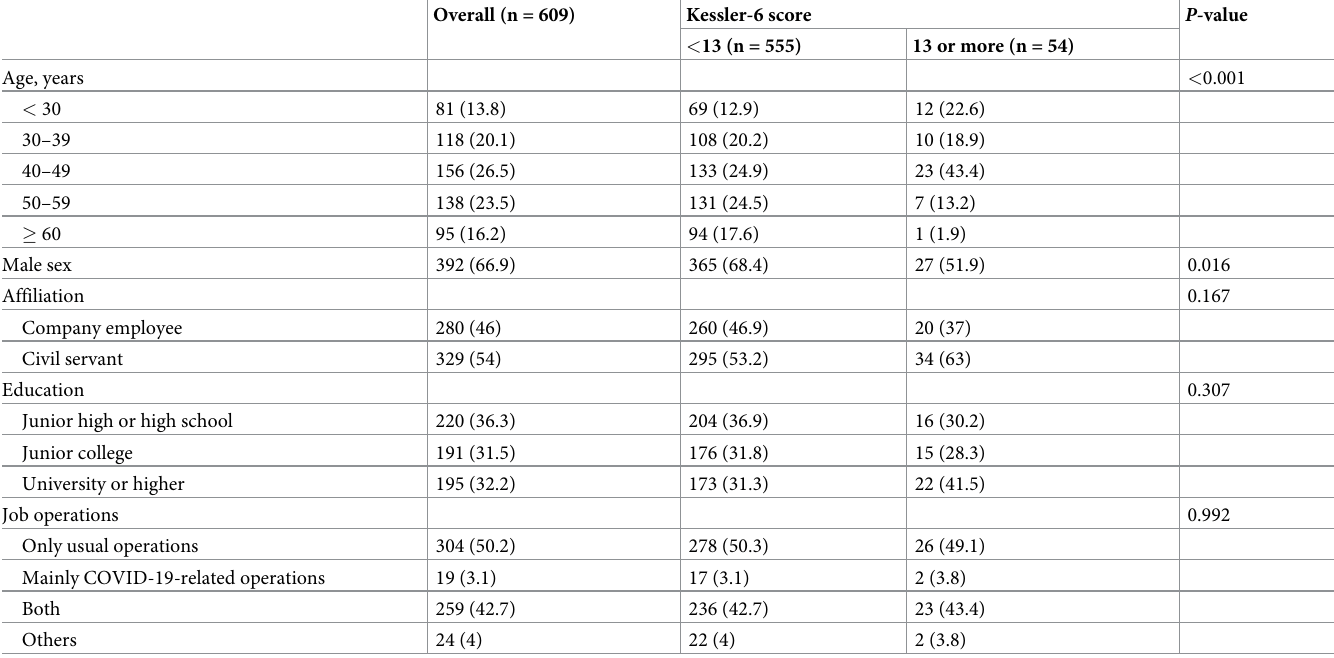
Table 2. Descriptive characteristics according to Kessler-6